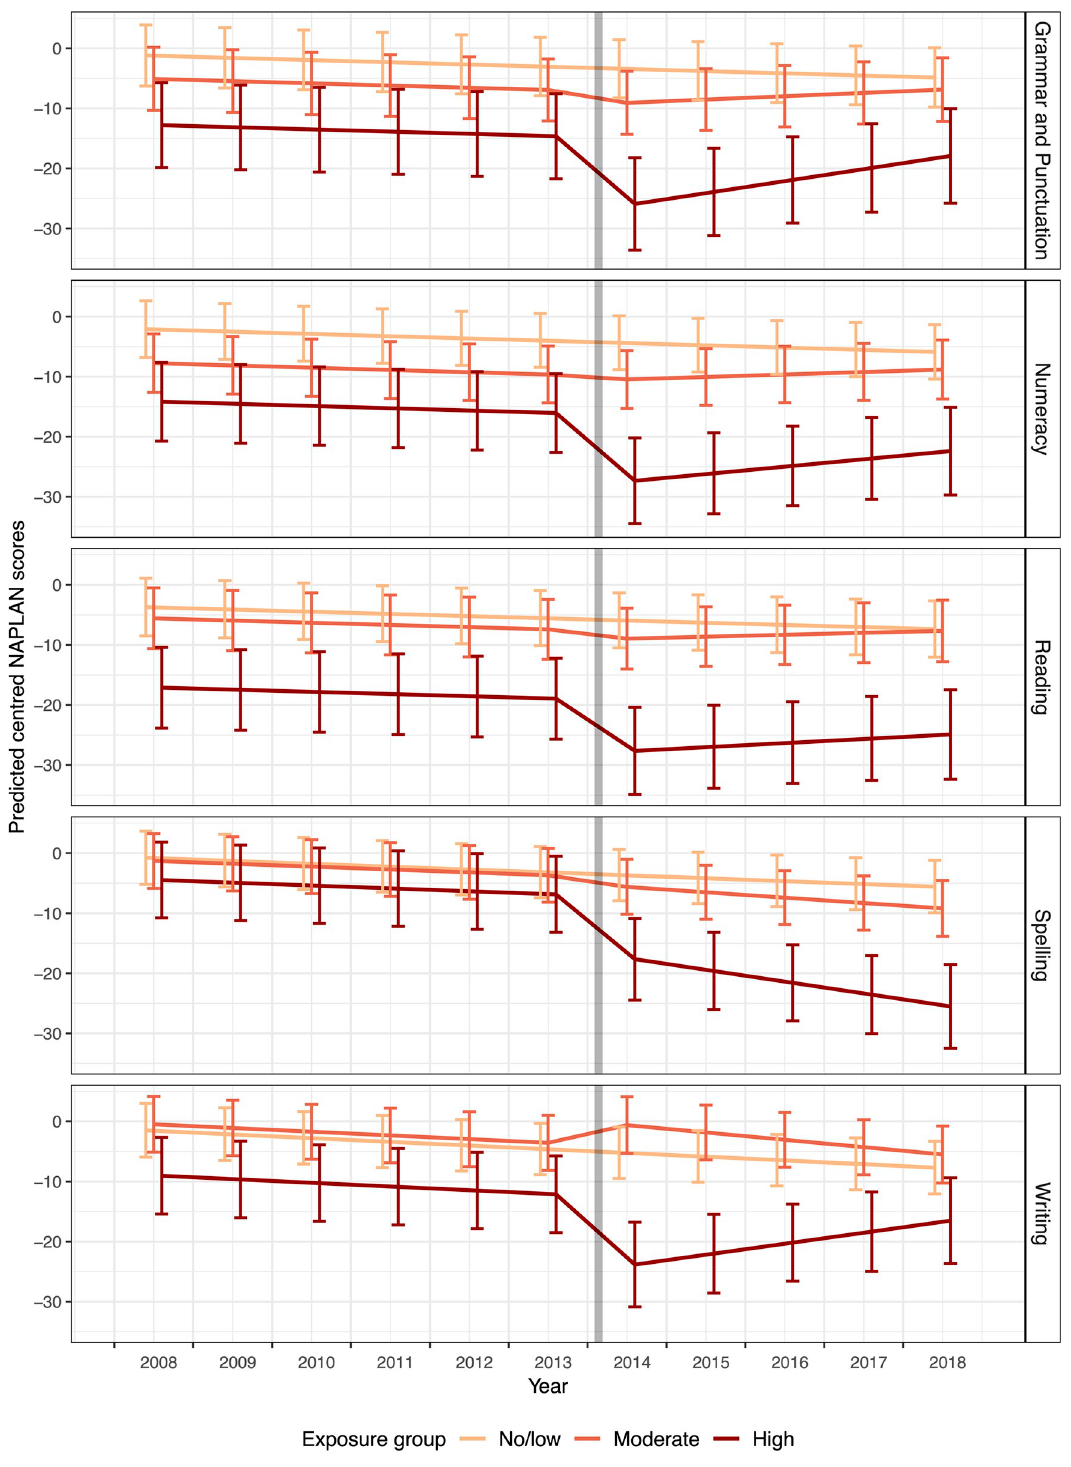
Fig 4. Trends of predicted centred NAPLAN scores (predicted margins when all covariates are fixed at reference values) with error bars by exposure group for each academic domain. Note: centred NAPLAN scores represent score differences of schools compared with the regional Victorian average scores in the matching year, grade level and domain; the grey line indicates the time of the mine fire.